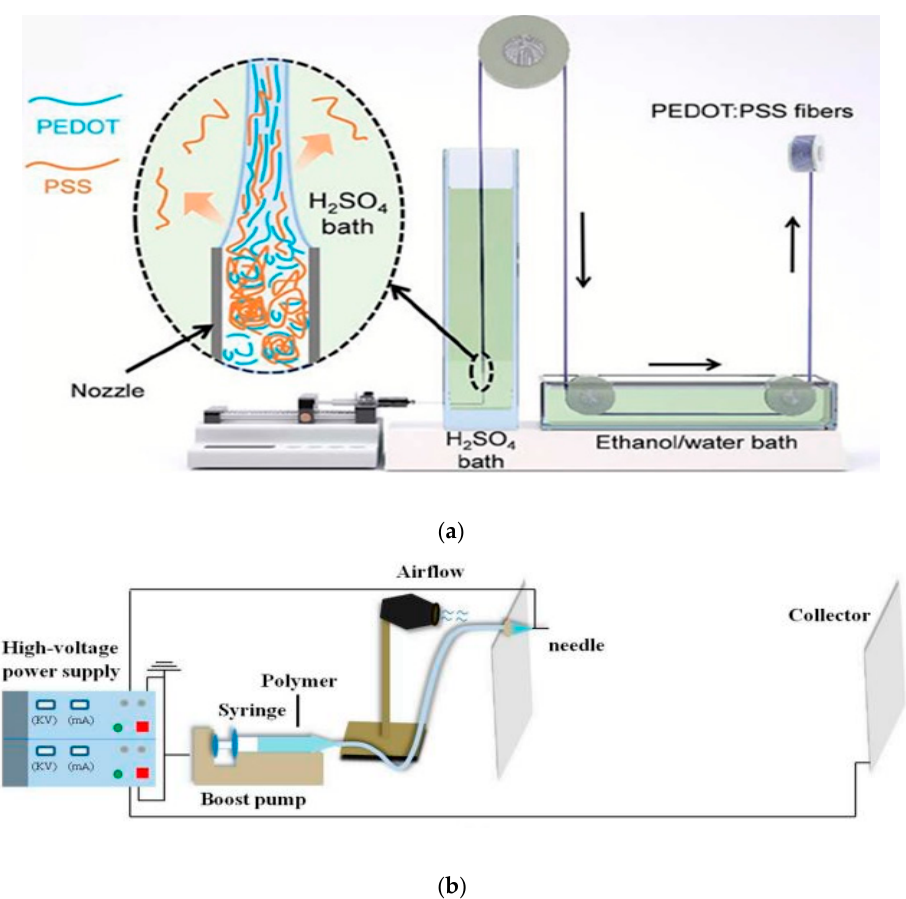
Figure 3. Fiber spinning process: ( a ) schematic illustration modified set-up used in wet-spinning PEDOT:PSS fibers. Inset shows the schematic illustration of the alignment of PEDOT:PSS chains during fiber formation and the outward diffusion of excess PSS to H 2 SO 4 coagulation bath. Adapted from [74] ; ( b ) schematic diagram of electrospinning setup; the distance between the needle and collector was 120 cm. Adapted from [77] .